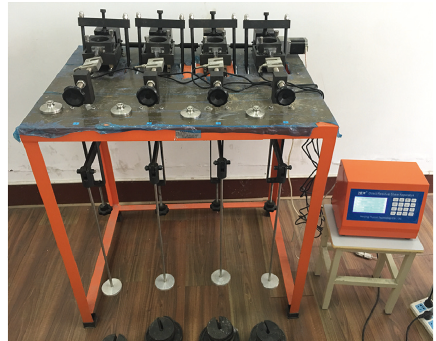
Figure 4: Fully automatic quadruple direct shear apparatus.